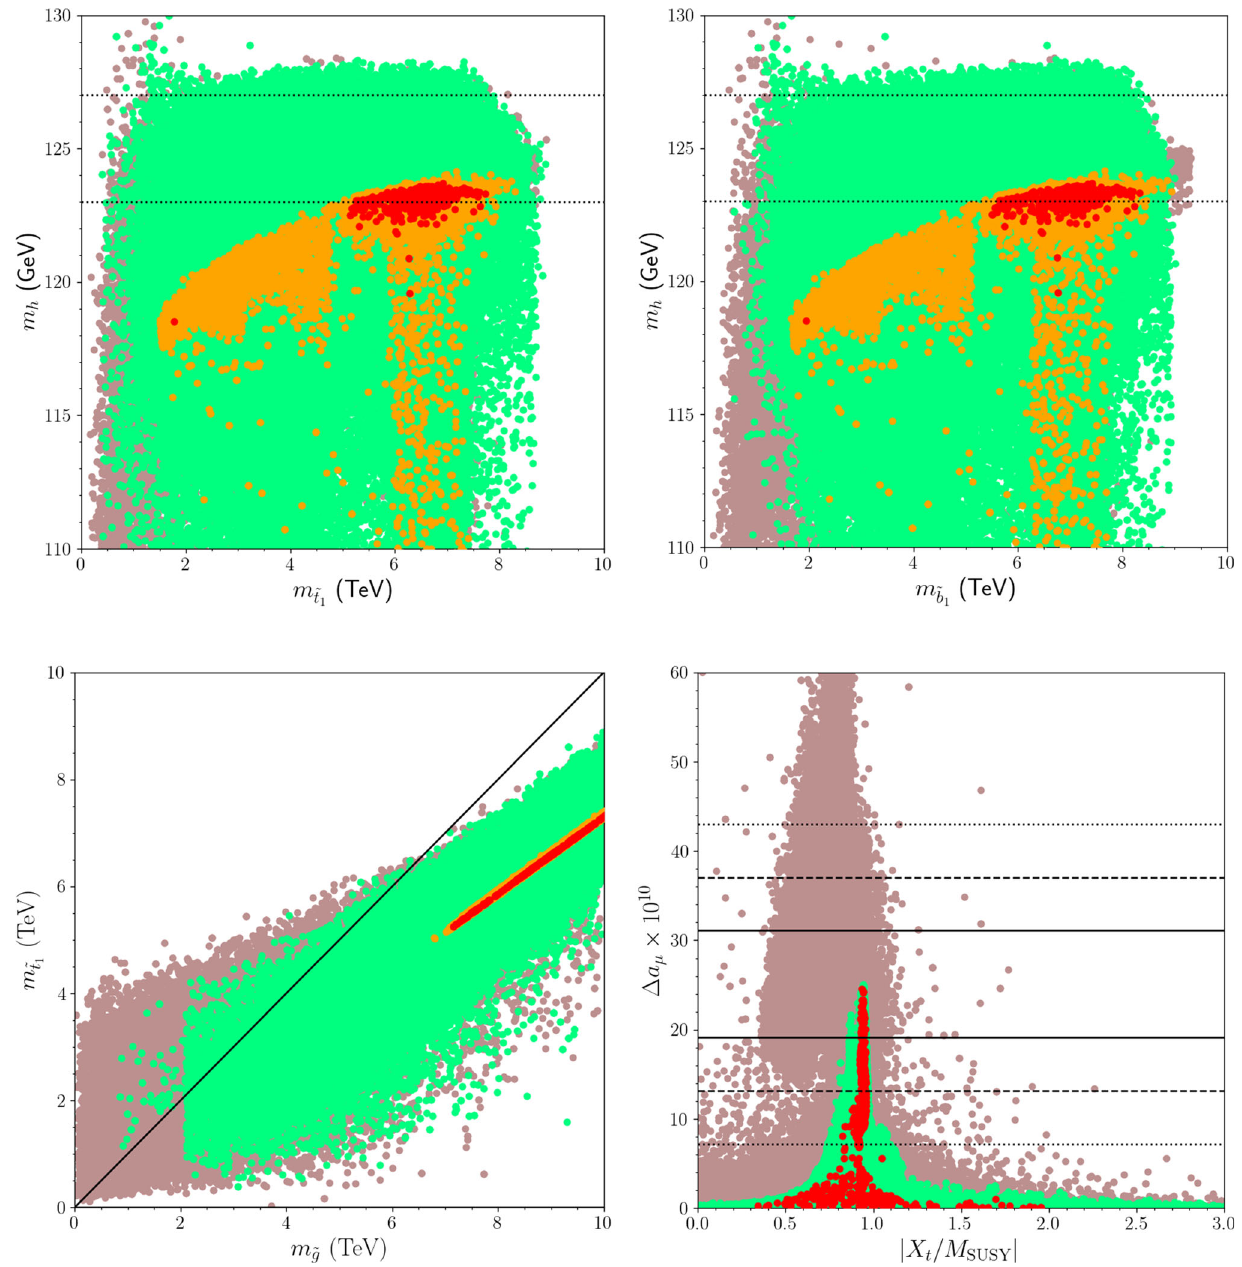
− m ˜ (cid:5) a μ − Fig. 5 The plots in the m h − m ˜ t , m h − m ˜ , m ˜ t the Planck measurements on relic abundance of LSP neutralino within g and b 1 1 1 X t / M SUSY planes, where X t = A t − μ cot β . All points are compatible 5 σ . In the top planes, the Higgs boson mass constraint is not included, with the REWSB and LSP neutralino conditions. Green points satisfy but it is shown with the horizontal dotted lines. In the (cid:5) a μ − X t / M SUSY plane 1 σ , 2 σ and 3 σ ranges of muon g − 2 measurements are displayed the mass bounds and constraints from rare B -meson decays. The orange by the horizontal solid, dashed and dotted lines, points form a subset of green and compatible with the muon g − 2 mea- surements within 2 σ . Red points, as a subset of orange, are allowed by